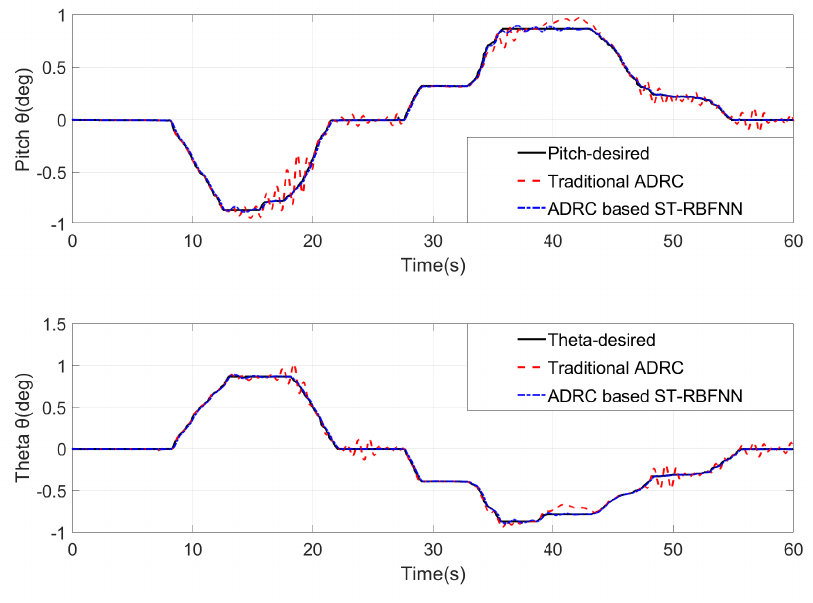
Figure 8. Flight attitude of quadrotor in Scenario